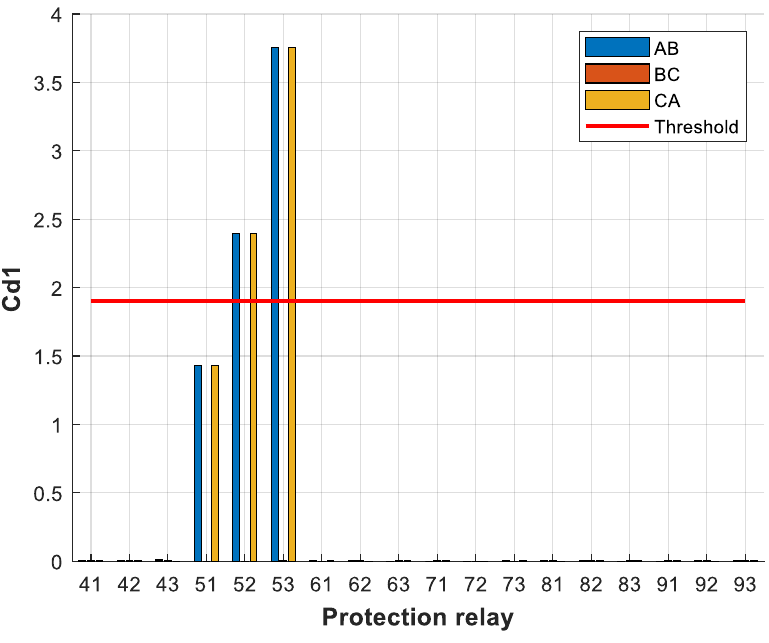
Figure 8. Differences in the current detail Cd1-dB2 at load A.